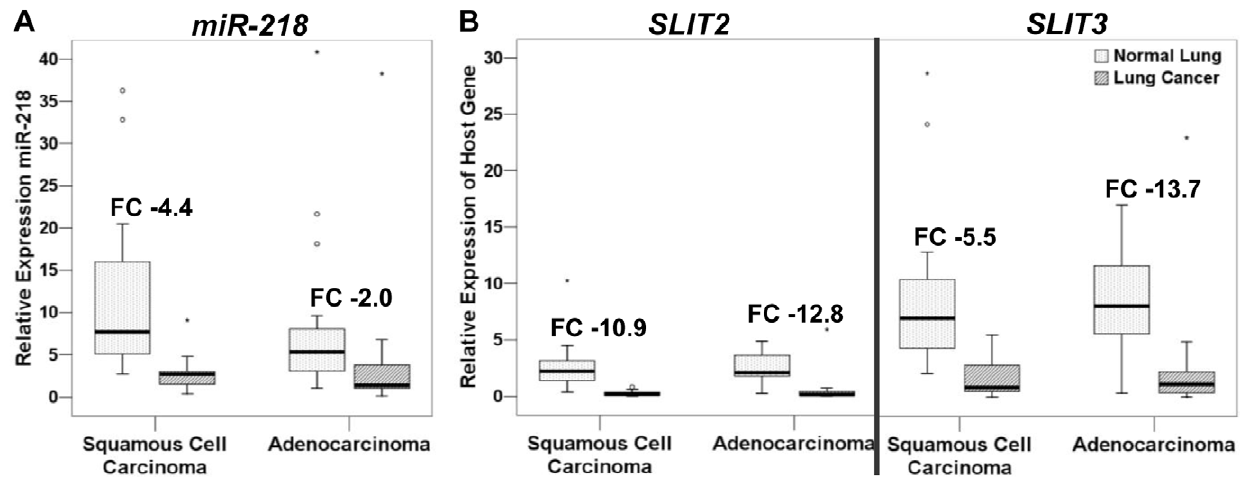
Figure 2. Expression of miR-218 and its host genes in primary NSCLCs and their paired normal lung. * p , 0.05; ** p , 0.01. (a) Down- regulation of miR-218 expression was observed in both ACs (FC -2; p=0.001; Z score = 2 3.258) and SCCs (FC 2 4.365; p , 0.0001; Z score = 2 4.406). (b) A reduction in host gene expression was observed in both ACs ( SLIT2 : FC 2 12.77, p , 0.0001, Z score = 2 4.277; SLIT3 : FC 2 13.73, p , 0.0001, Z score = 2 3.839) and SCCs ( SLIT2 : FC 2 10.85, p , 0.0001, Z score = 2 5.182; SLIT3 : FC 2 5.46, p , 0.0001, Z score = 2 4.540). Abbreviations: FC, Fold change.